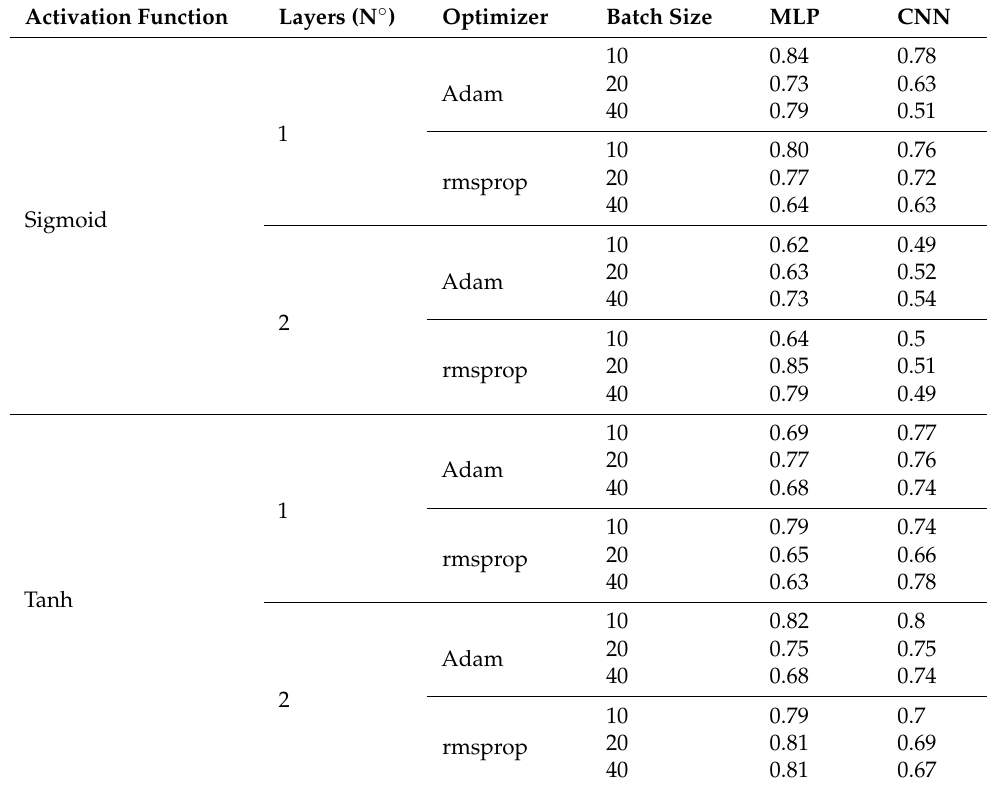
Table 2. Cont. Activation